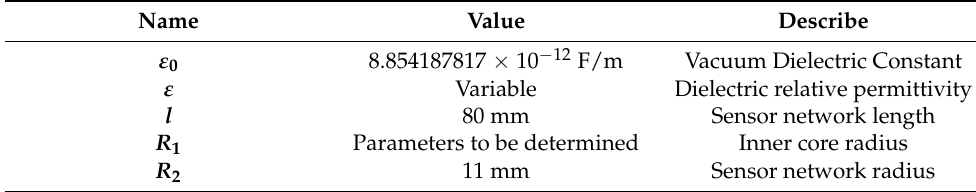
Table 5. Geometric parameter setting of sensor simulation model.